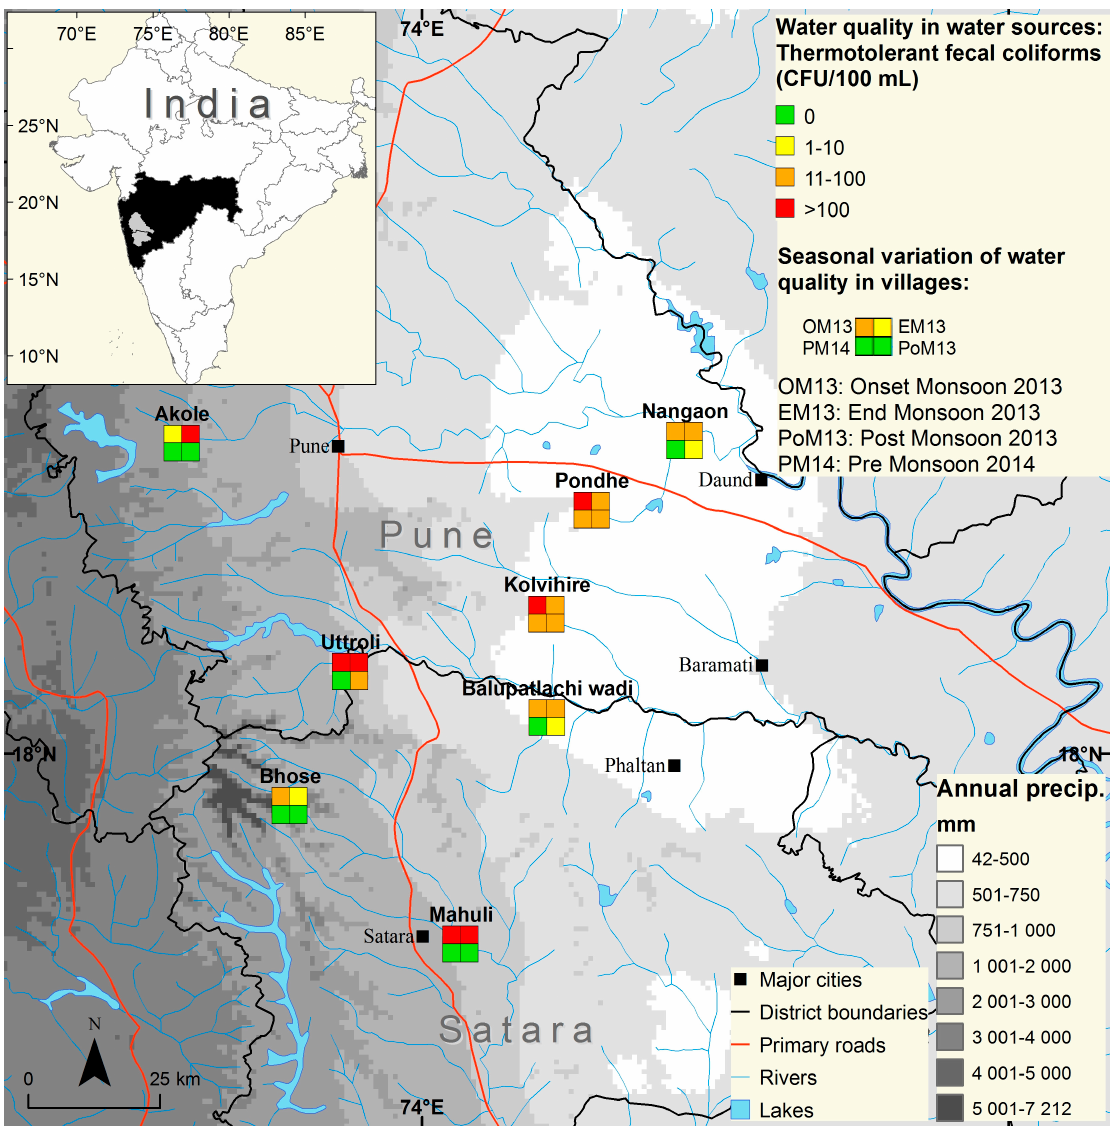
Figure 1. Study area and water quality during the sampling period. CFU, colony-forming unit.